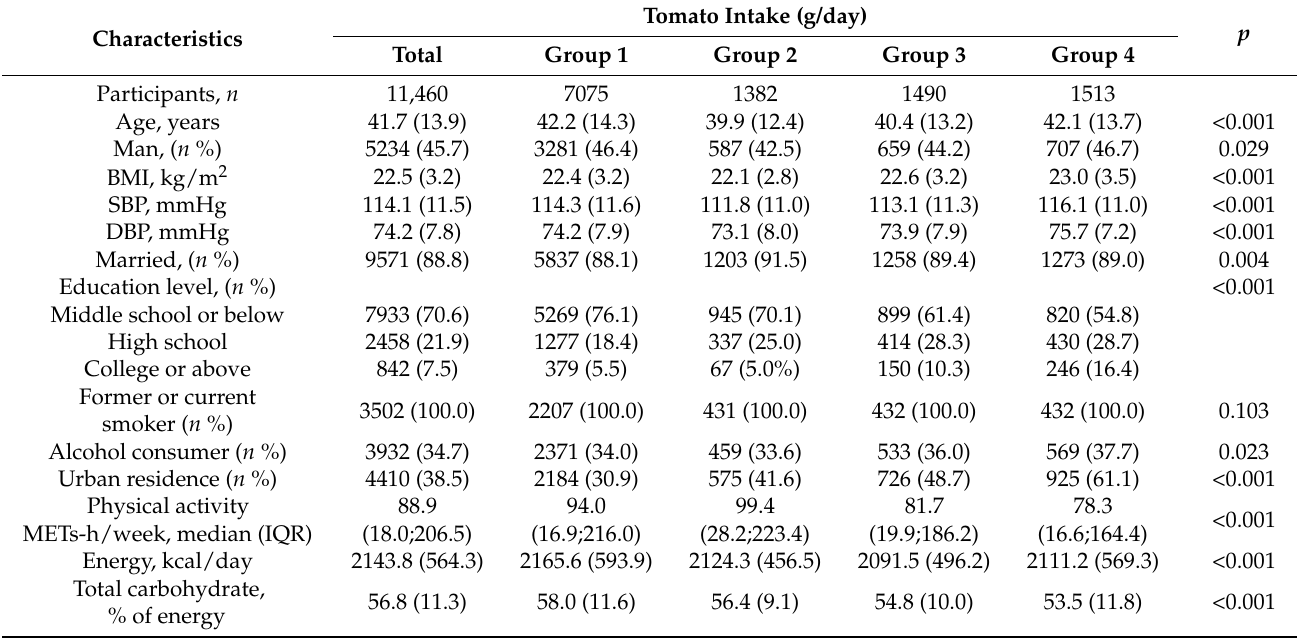
Table 1. Baseline population characteristics by total dietary tomato intake 1